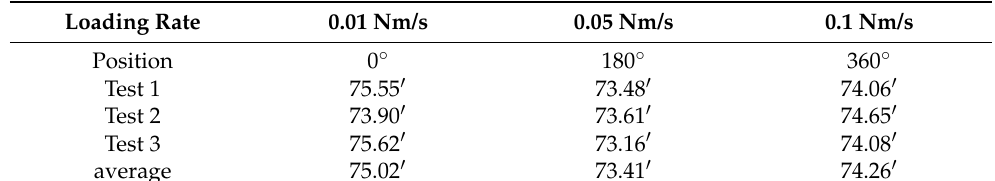
Table 9. Experiment results of δ e .